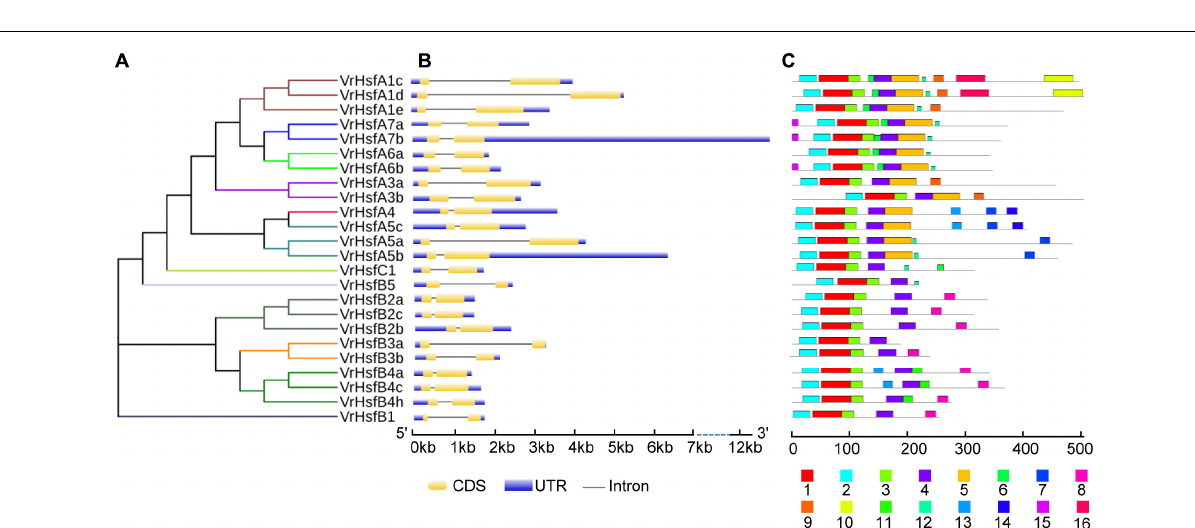
Frontiers in Genetics |